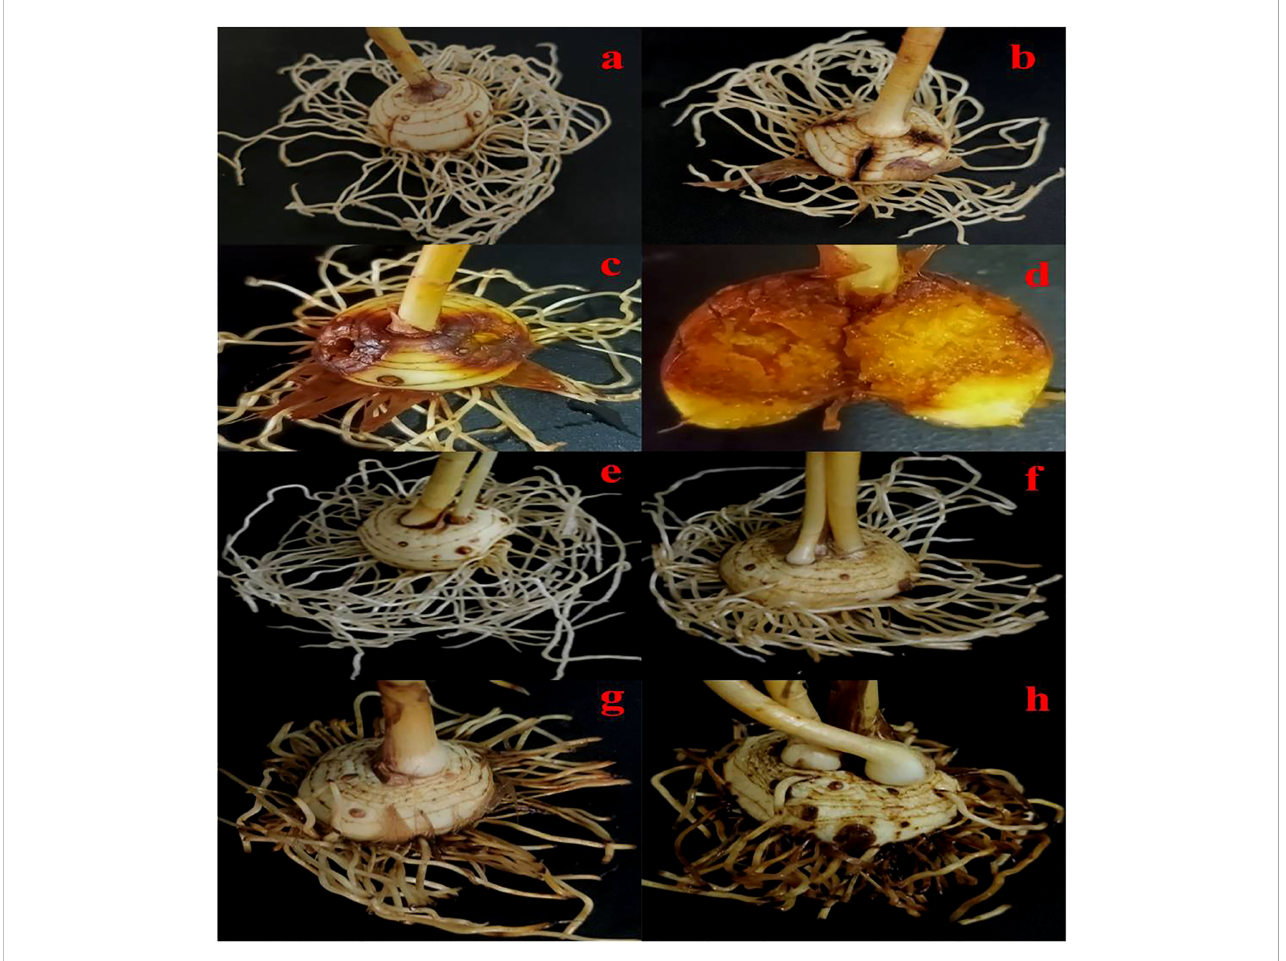
FIGURE 8 Symptoms of rot on saffron corms and roots caused by fungal isolates. (A) Poorly developed symptoms on corms, (B) moderate symptoms of corm rot, (C,D) severe corm rot, (E) no symptoms of saffron root rot, (F) poorly developed symptoms on roots, (G) moderate symptoms of root rot, and (H) severe root